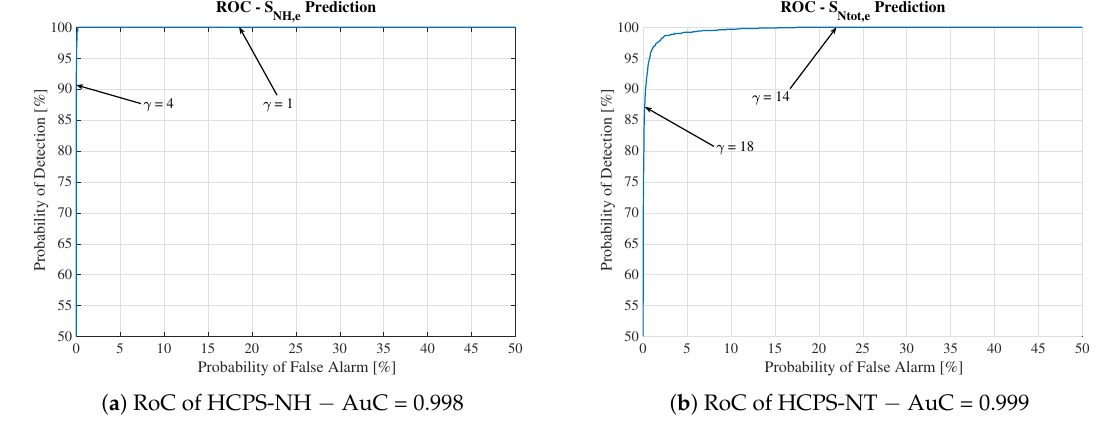
Figure 12. Receiver operating characteristic (RoC) curves for HCPS